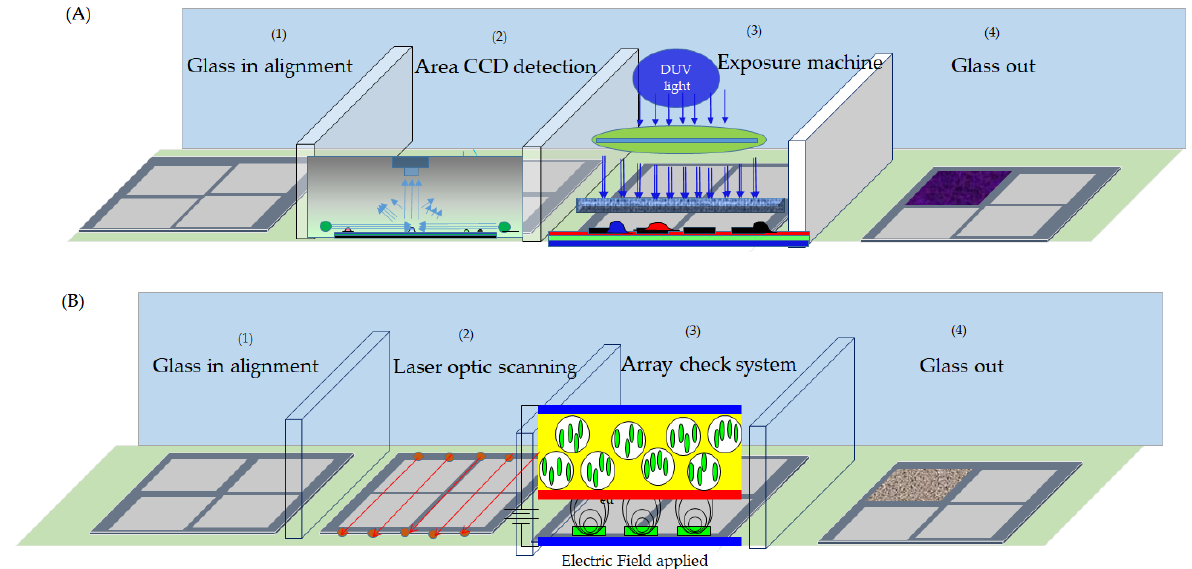
Table 1. The parameters for optical detection of the debris on the color filter.